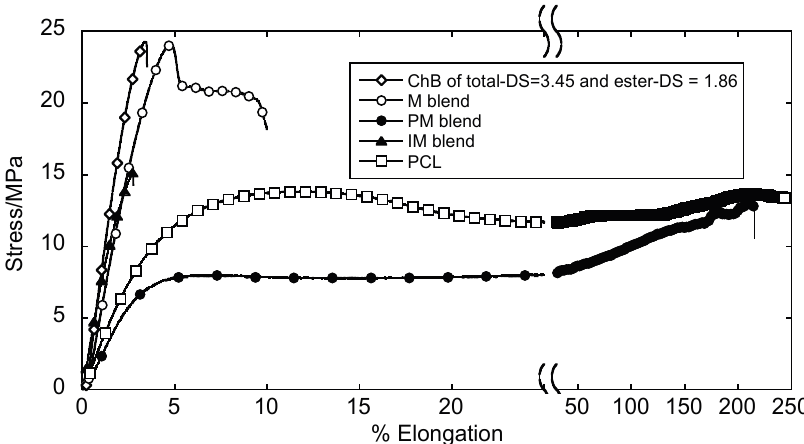
Figure 15. Stress–strain curves of ChB (total-DS = 3.45; ester-DS = 1.86) and PCL and their IM, PM, and M blends (ChB/PCL = 50/50 ( w / w )). Reproduced with permission from ref. [46]. Copyright 2014 Elsevier Ltd.